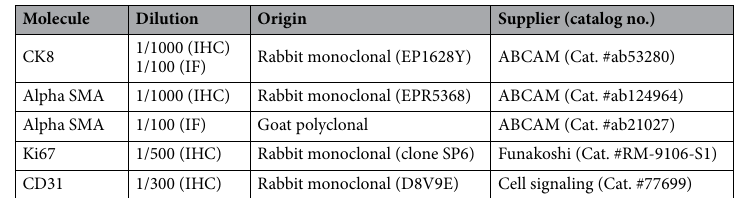
Table 1. The list of the primary antibodies for